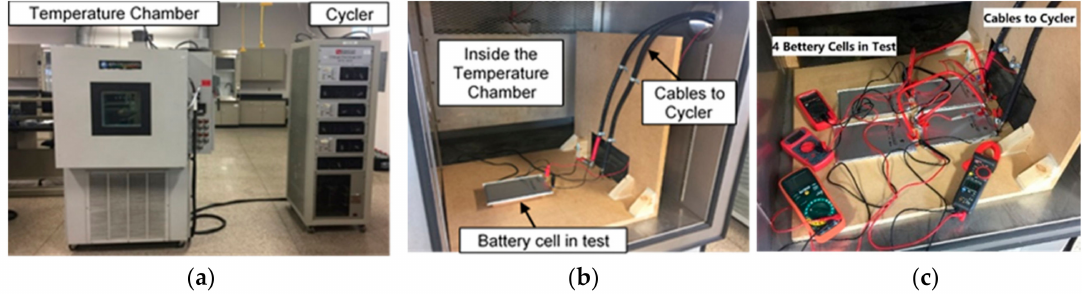
Figure 6. Battery experimental test setup: ( a ) Cycler and chamber; ( b ) cell testing; ( c ) module